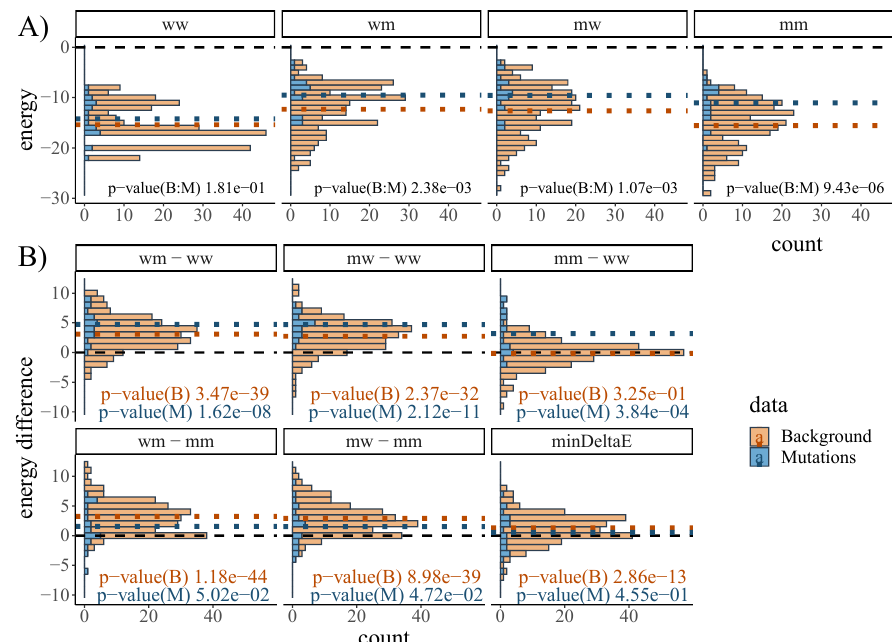
Figure 4. ( A ) Minimum free energy (MFE) distributions of known single-nt GC-mutating CoMs and their background model. The ’Mutations’ data (blue hues) covers 22 CGCG CoMs known from literature, while the ’Background’ data (orange hues) aggregates all remaining 207 CGCG CoMs from the MFE RRIs containing the known CoMs. There are four possible sequence combinations, referring to sRNA-mRNA pairs with respective (w)ildtype/(m)utant annotation. That is, an interaction of wildtype sRNA with the mutated mRNA is denoted by ’wm’, while e.g., ’mm’ refers to the interaction of sRNA and mRNA mutant. Each subplot provides the p-value of the sample t-test comparing the respective distributions. Dotted lines mark mean values, while dashed black lines highlight an energy difference of zero; ( B ) Pairwise energy differences of mutant combinations compared to wildtype-only ’ww’ or mutant-only ’mm’ MFEs for the CoMs of both the Mutations and Background data set. That is, e.g., ’wm-mm’ refers to the energy difference of a ’wm’ interaction and the respective mutant-only ’mm’ interaction energy. For each data set, p-values of paired sample t-tests that compare the values with the respective reference MFEs (’ww’ or ’mm’) are provided. The minDeltaE feature is defined as (min(MFE(mw),MFE(wm))-max(MFE(ww),MFE(mm))). For further details, see